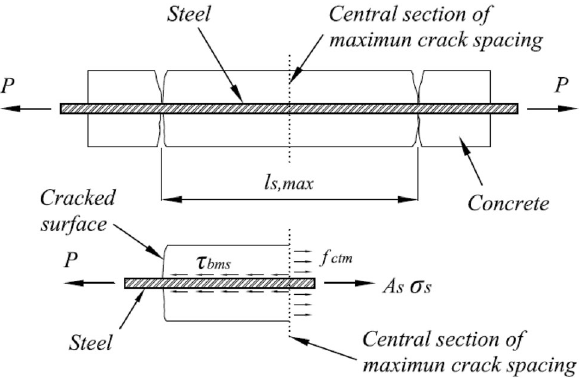
Fig. 5 Equilibrium between the tensile force and the bonding force in the free body of the